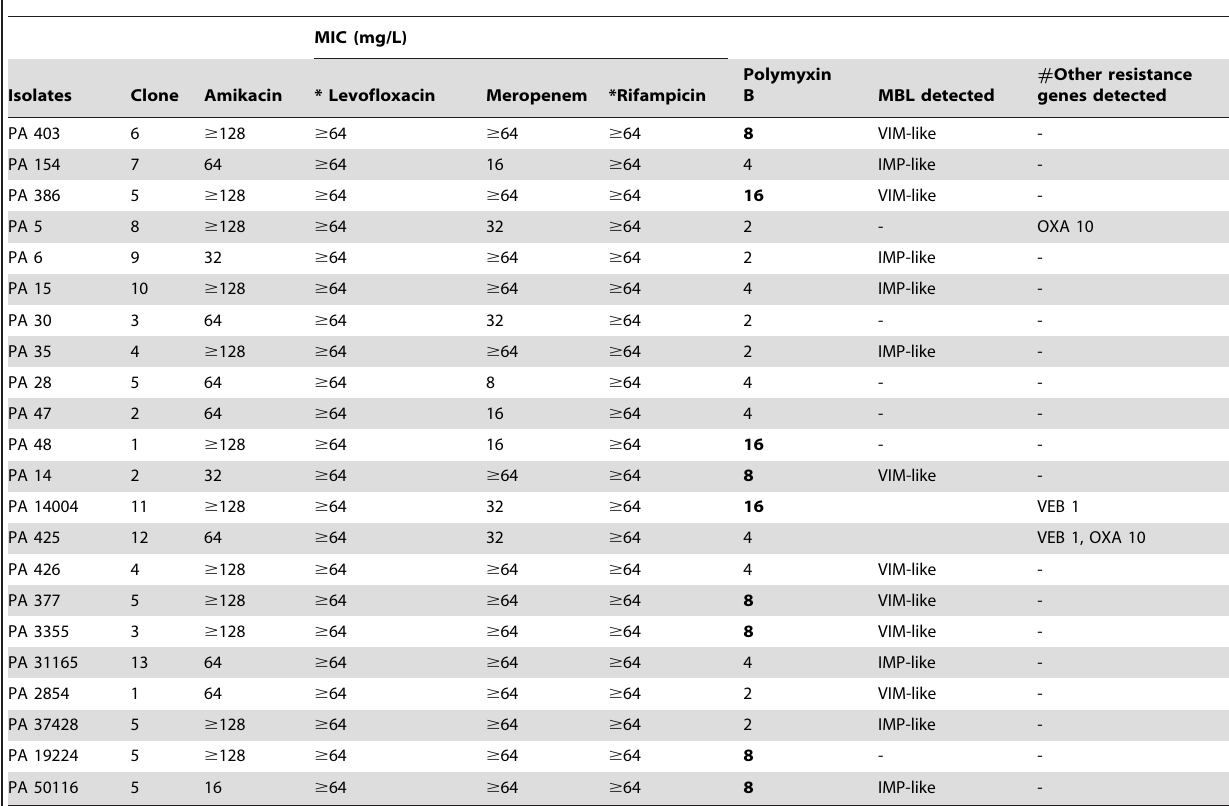
Table 1. Susceptibilities, MBL gene(s) detected and clonal grouping of XDR PA isolates.